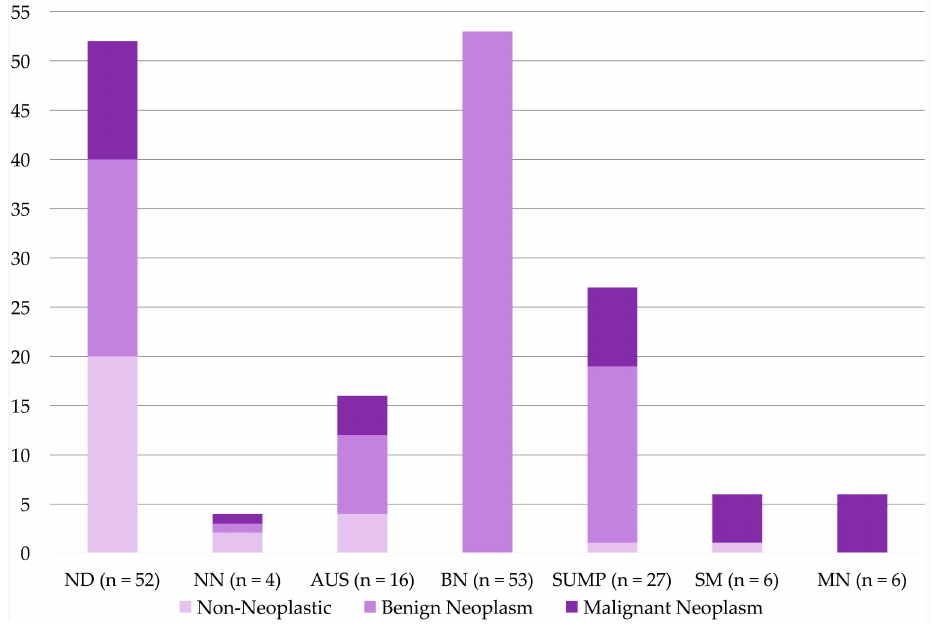
Figure 2. Milan System for Reporting Salivary Gland Cytopathology: histological diagnoses of non-neoplastic, benign neoplasm and malignant neoplasm in each Milan category. The present study material consisted of 111 histologically proven neoplastic cases with the CBs available. CBs with less than 10 cells were all ( n = 28) non-contributory for diagnosis, and those with 10–50 cells ( n = 24) were crucial for diagnosis in 21%, supported the diagnosis in 75% and were non-contributory in 4% of cases ( p < 0.001) (Table 3). Table 3. Contribution of Cell Blocks for Cytological Diagnosis was analyzed at four different levels: CB cellular- ity, CB method, MSRSGC categories and accuracy, which were compared with the CBs’ contributory role in the final cytological